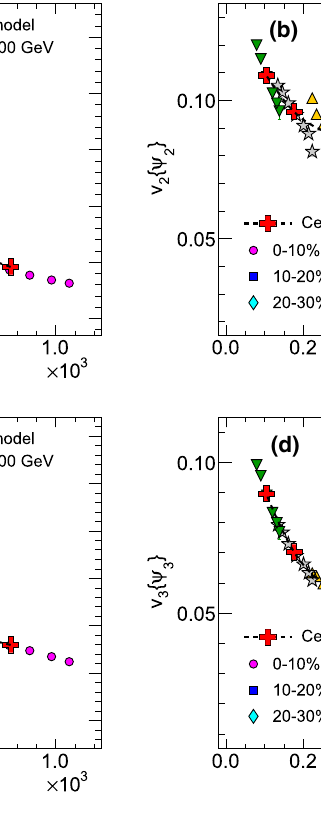
Fig. 3 Plotsforminimum-biasAu+Aucollisionsat Top row: (left) ε 2 vs. d N ch / d η ; (right) v 2 vs. d N ch / d η . Bottom row: (left) ε 3 vs. d N ch / d η ; (right) v 3 vs. d N ch / d η . Centrality average val-